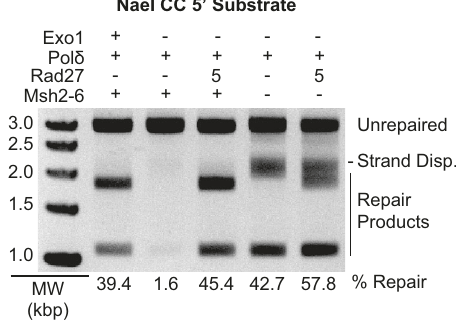
Fig. 3 Both Rad27 and Msh2-Msh6 are required to form only mature repair product bands. Assays of 5 ′ nick-directed repair of the CC substrate, in which different proteins were omitted or substituted as indicated. The amount of Rad27 used is indicated in pmole. All reactions also contain PCNA, RFC- Δ 1N, and RPA. Other than Rad27, the amounts of all proteins used in the assays are as listed in the “ Methods ” section. MW, molecular weight markers. The percent repair corresponds to the fraction of all DNA in each individual lane susceptible to PstI cleavage, including those labeled “ strand displacement ” and “ repair products ” . Three independent experiments were